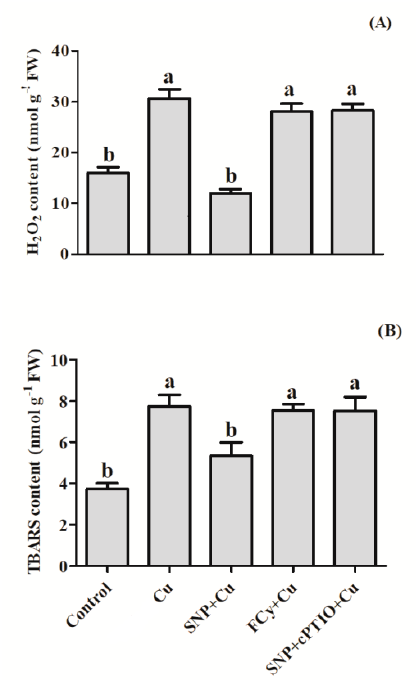
Figure 3. H 2 O 2 ( A ) and TBARS ( B ) content in germinating seeds of Indian mustard ( Brassica juncea L.). Seeds were germinated with/without Cu stress and pre-treated with water, SNP, FCy (SNP analogue) and SNP + cPTIO (cPTIO as a specific NO-scavenger), later exposed to 3.0 mM Cu stress for 3 days. Same letters above bars show that data did not differ significantly by LSD test at p < 0.05. FW—fresh weight.